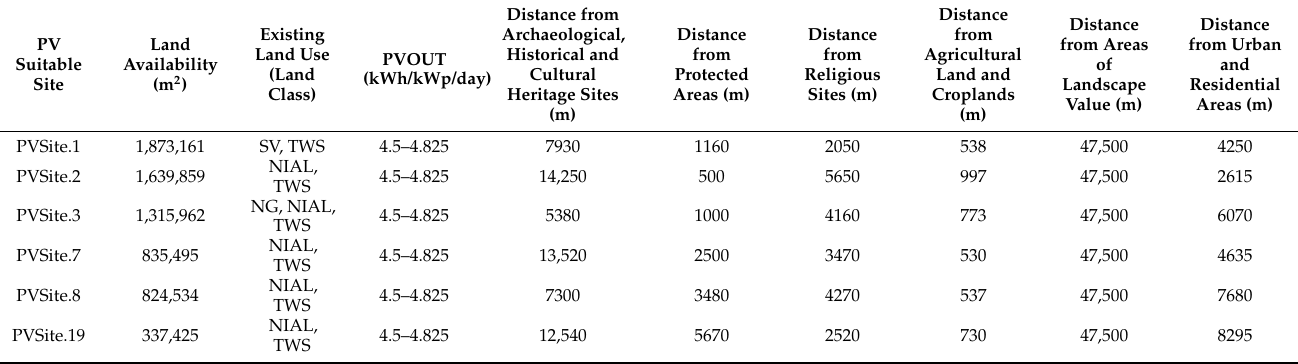
Table 7. The characteristics of the proposed highly suitable sites for PV farm installation according to the benefit PVAC. Note: SV, sclerophyllous vegetation, SV; TWS, transitional woodland shrub; NG, natural grasslands; NIAL, non-irrigated arable land.